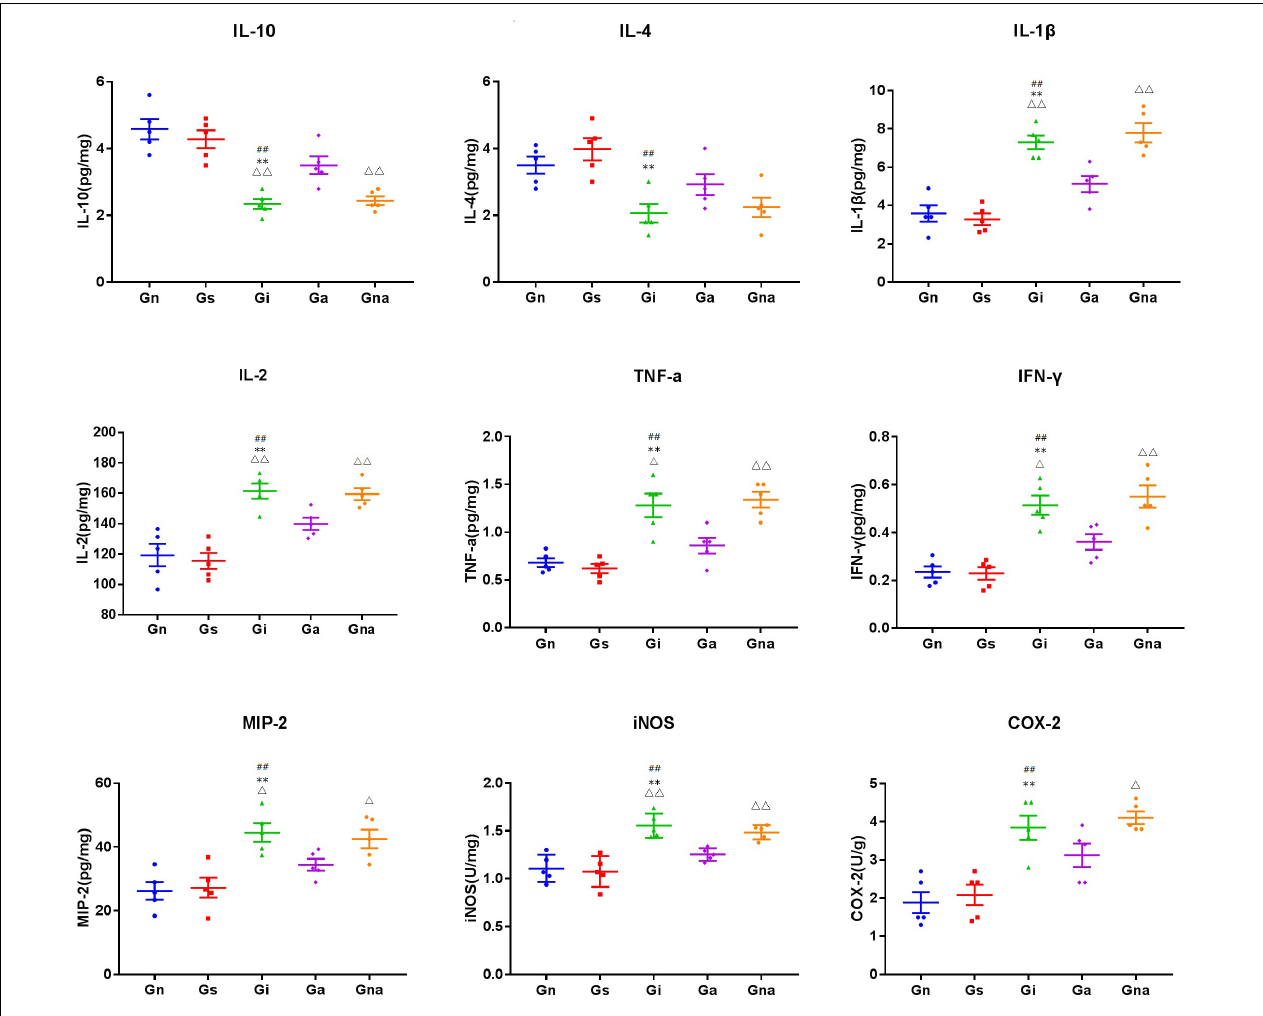
FIGURE 7 | Effect of acupuncture on the levels of related inflammatory mediators in the hippocampus. The data are expressed as the mean ± SEM ( n = 5). ** P < 0.01, vs. Gn group; # P < 0.05, ## P < 0.01, vs. Gs group; (cid:77) P < 0.05, (cid:77)(cid:77) P < 0.01, vs. Ga group. Gn, normal group; Gs, sham-operated group; Gi, impaired group; Ga, acupoint group; Gna, non-acupoint